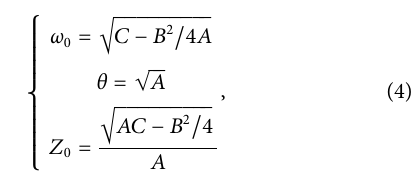
Where ω 0 , θ , and Z 0 denote the beam waist radius, beam divergence angle, and Rayleigh length at the focal plane, respectively. We took the combination ② + ⑥ as an example, and its spot size and fi tted data are shown in Figure 2D. The NA, beam waist radius, and Rayleigh length obtained according to Eq. 4 were 0.238, 63.903 μ m, and 0.268 mm, respectively.